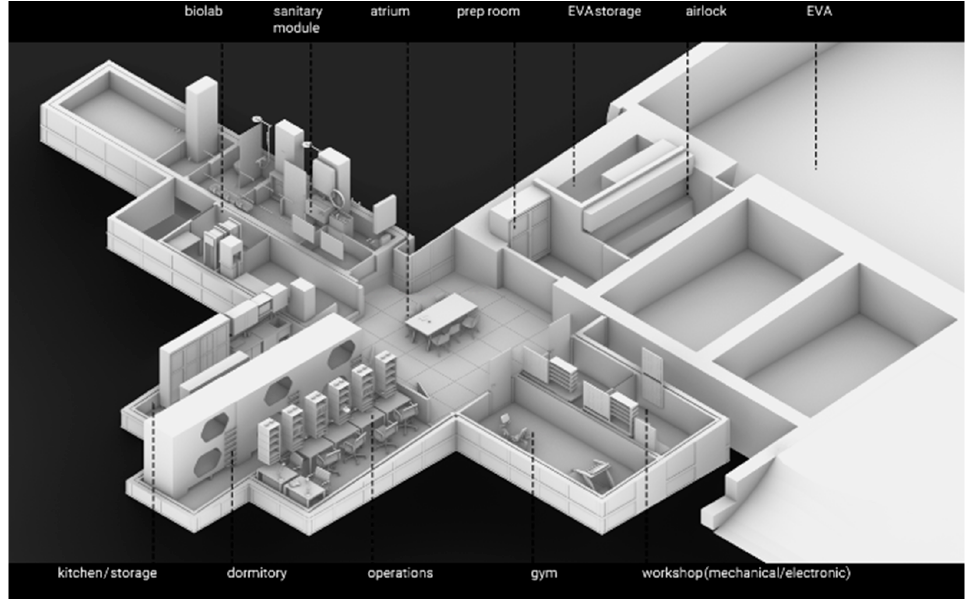
Figure 3. The infrastructure of the analogue space station in Pi ł a .